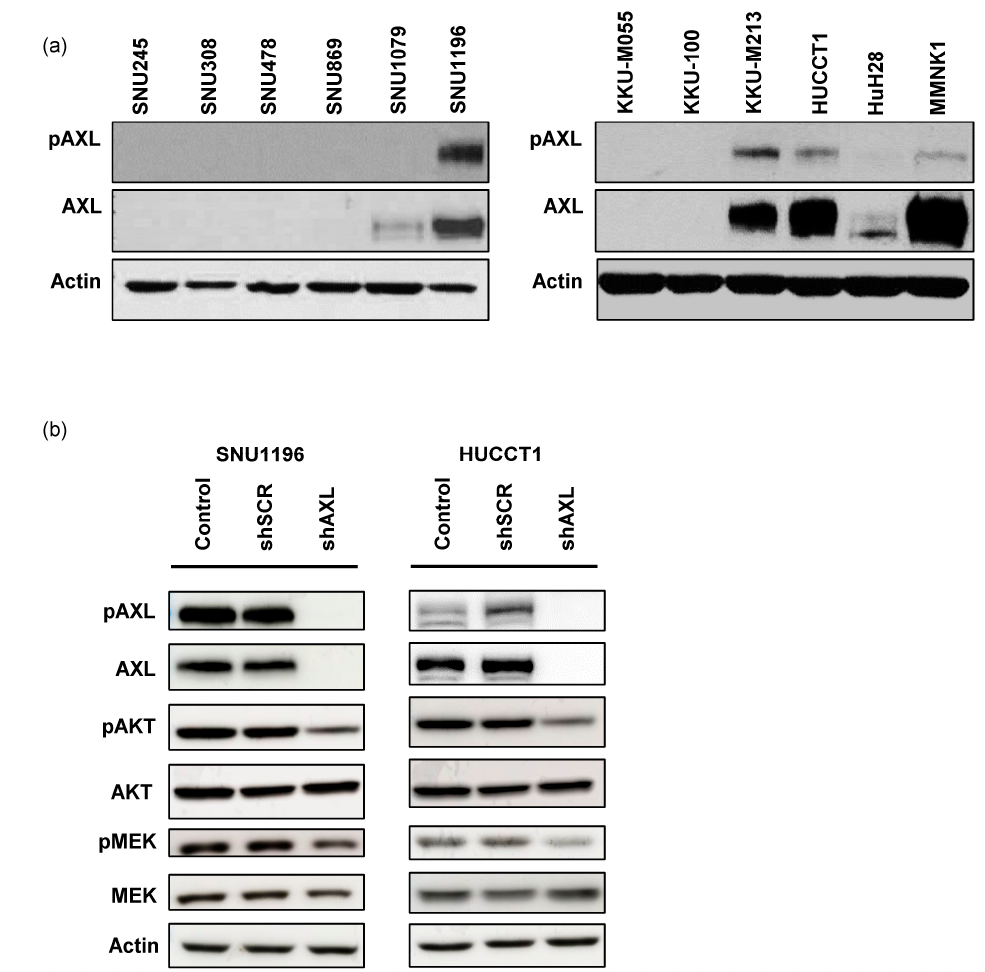
Figure 2. AXL expression in bile duct cancer cells. ( a ) The expression of AXL and phospho-AXL in bile duct cancer cell lines. In this study, we focused on SNU1196 and HUCCT1 with high expression of phospho-AXL and AXL. ( b ) In SNU1196 and HUCCT1 cells, AXL expression was knocked down using shRNA, resulting in reduced expression of phospho-AKT and phospho-MEK (shSCR: shRNA with scrambled sequences, shAXL: shRNA targeting AXL). Original blot see Supplementary File S1. To determine whether AXL plays an essential role in the progression of bile duct can-